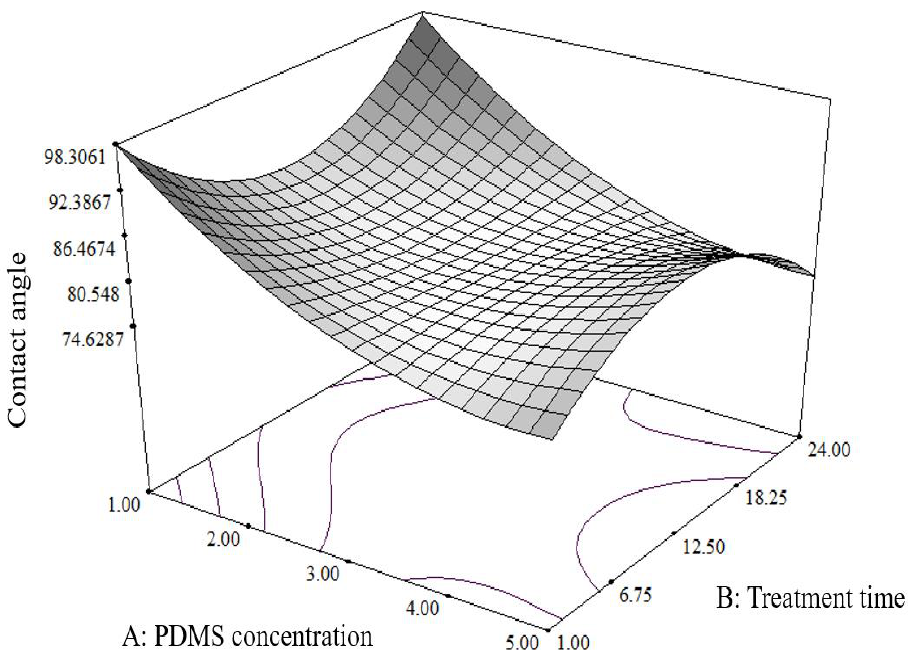
Figure 4. Response surface plot of PDMS concentration versus treatment time on the contact angle value of the stainless steel substrate.